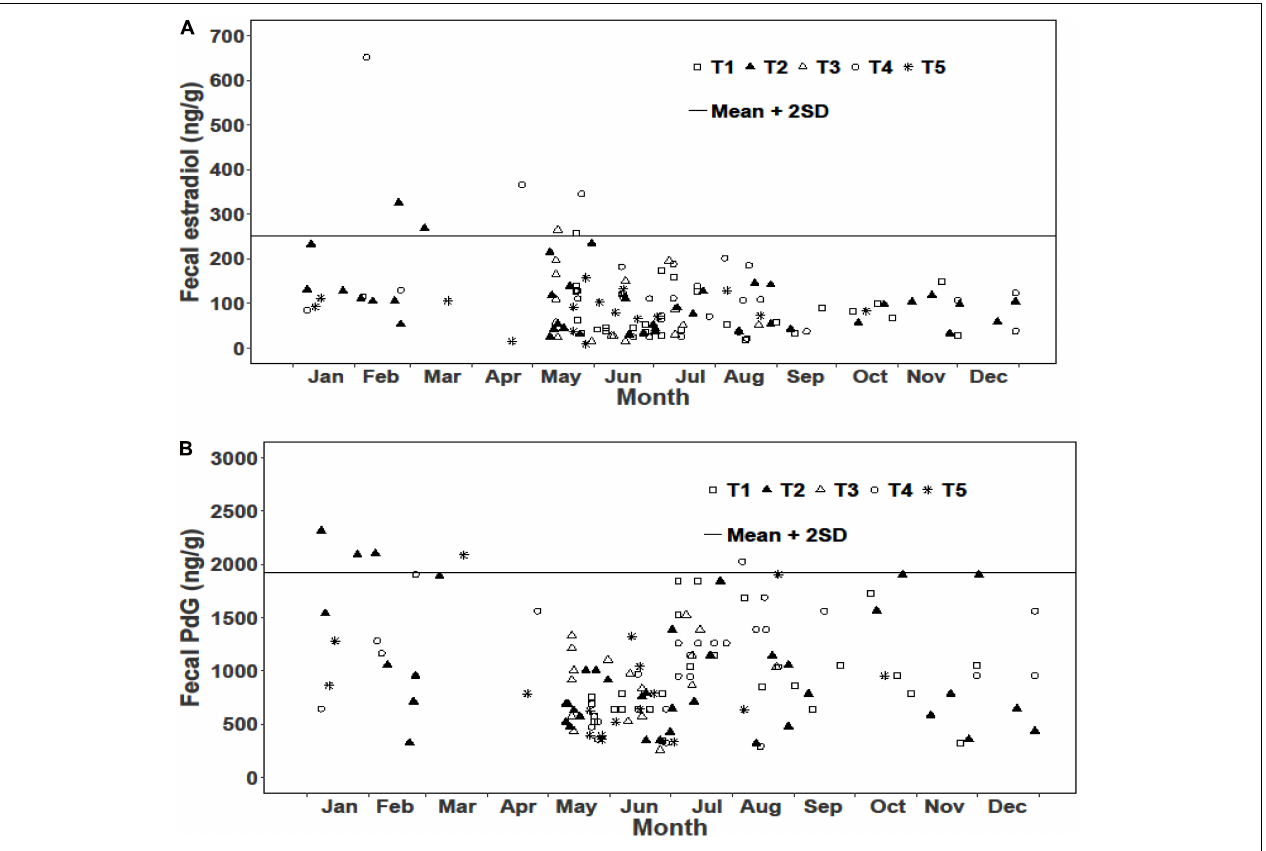
FIGURE 3 | Fecal hormone metabolite concentrations in musk deer in various sampling trails (T1, T2, T3, T4, and T5) (A) Estradiol; (B) PdG.